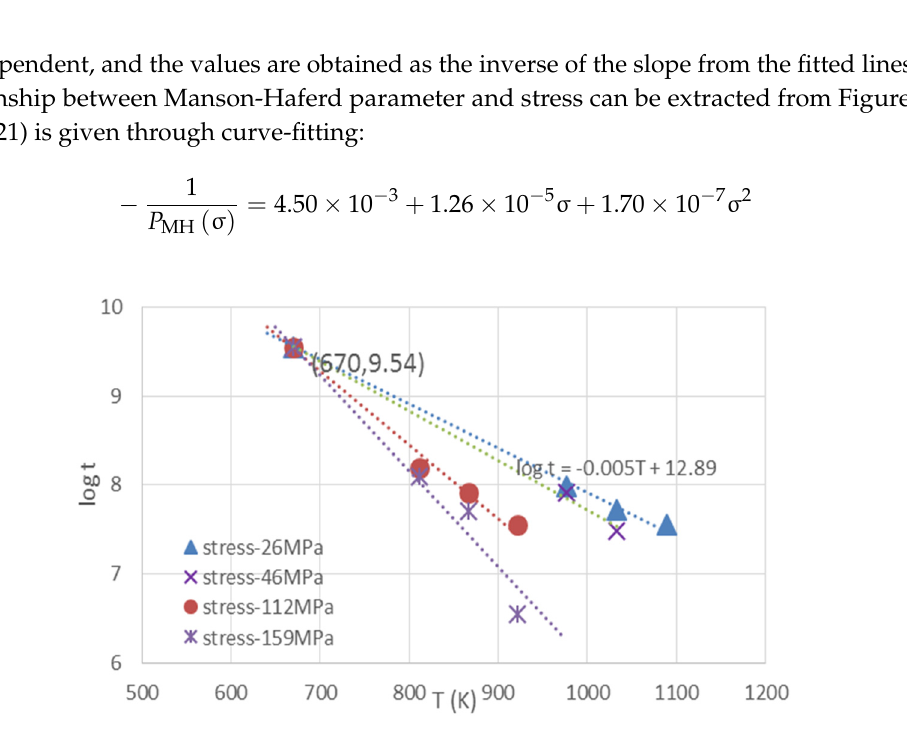
Figure 2. The P MH ( σ , T , t ) parameter of AISI stainless steel 316. Data extracted from [26].